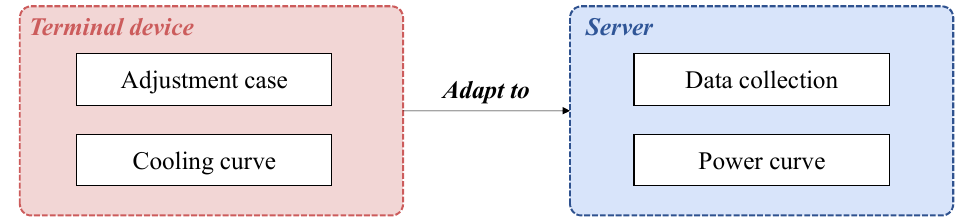
Figure 2. The regulation principle of the terminal device.